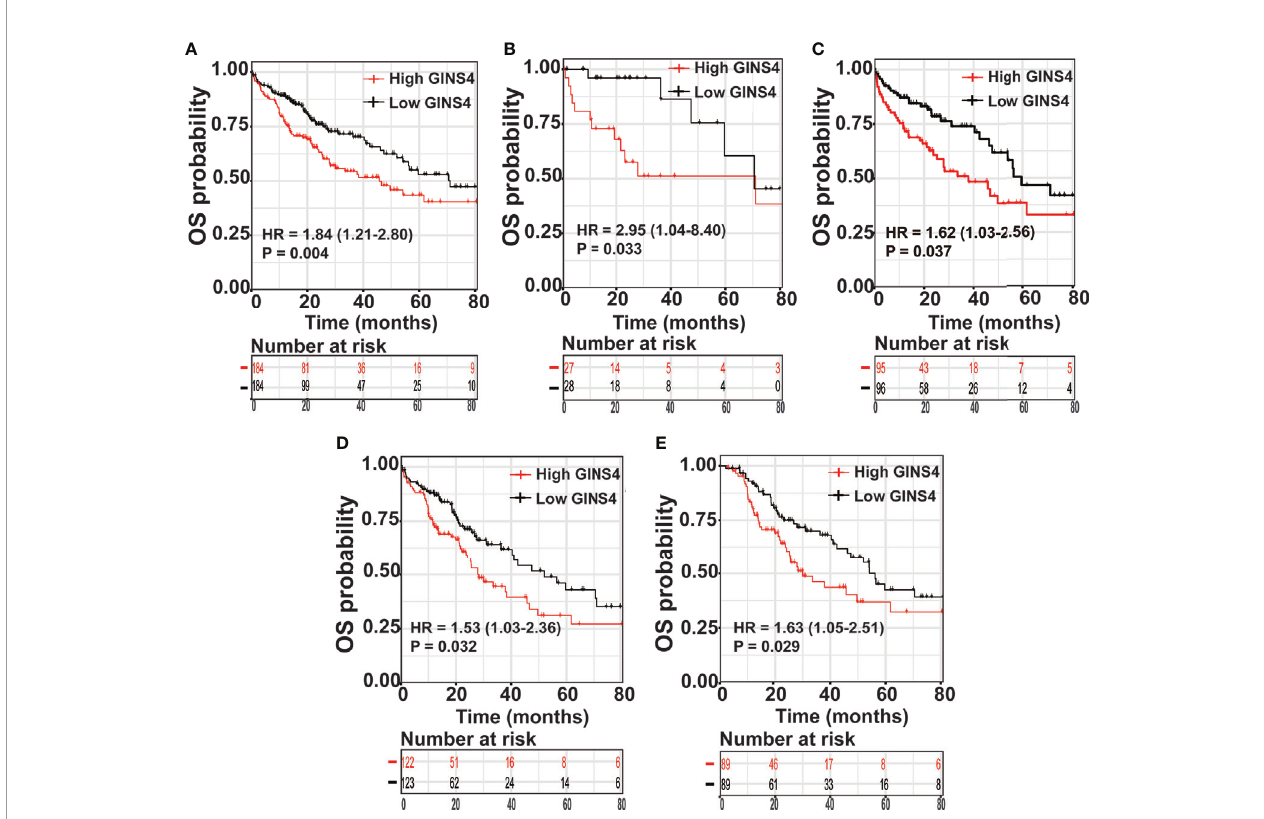
FIGURE 8 | High GINS4 expression is a signi fi cantly adverse prognostic factor in HCC patients. Survival analysis shows that elevated GINS4 expressions predicts poor prognosis in (A) all HCC patients from the TCGA database, (B) HCC patients at histological grade 1, (C) HCC patients with age >60 years old, (D) HBV infection-negative HCC patients, and (E) HCC subgroup with relapse. OS, overall